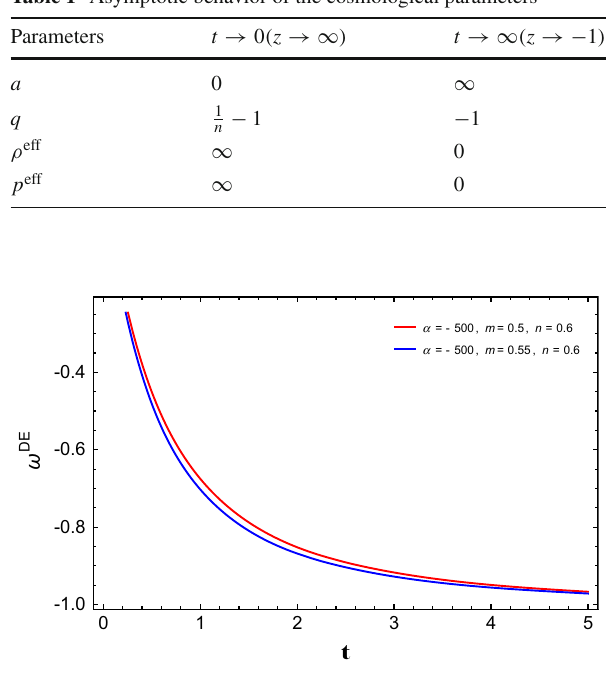
Fig. 9 Evolution of ω DE in time